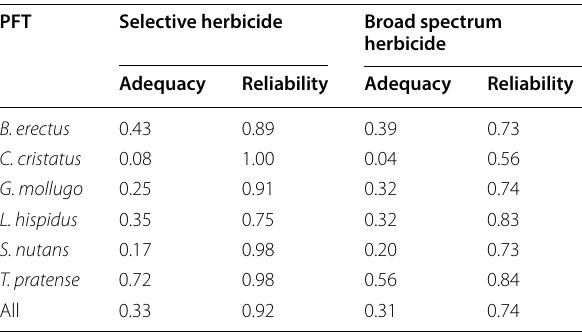
Table 6 Model fit for the